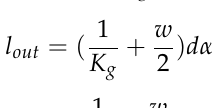
Figure 2. Linear placement and lateral bending of prepreg tow.